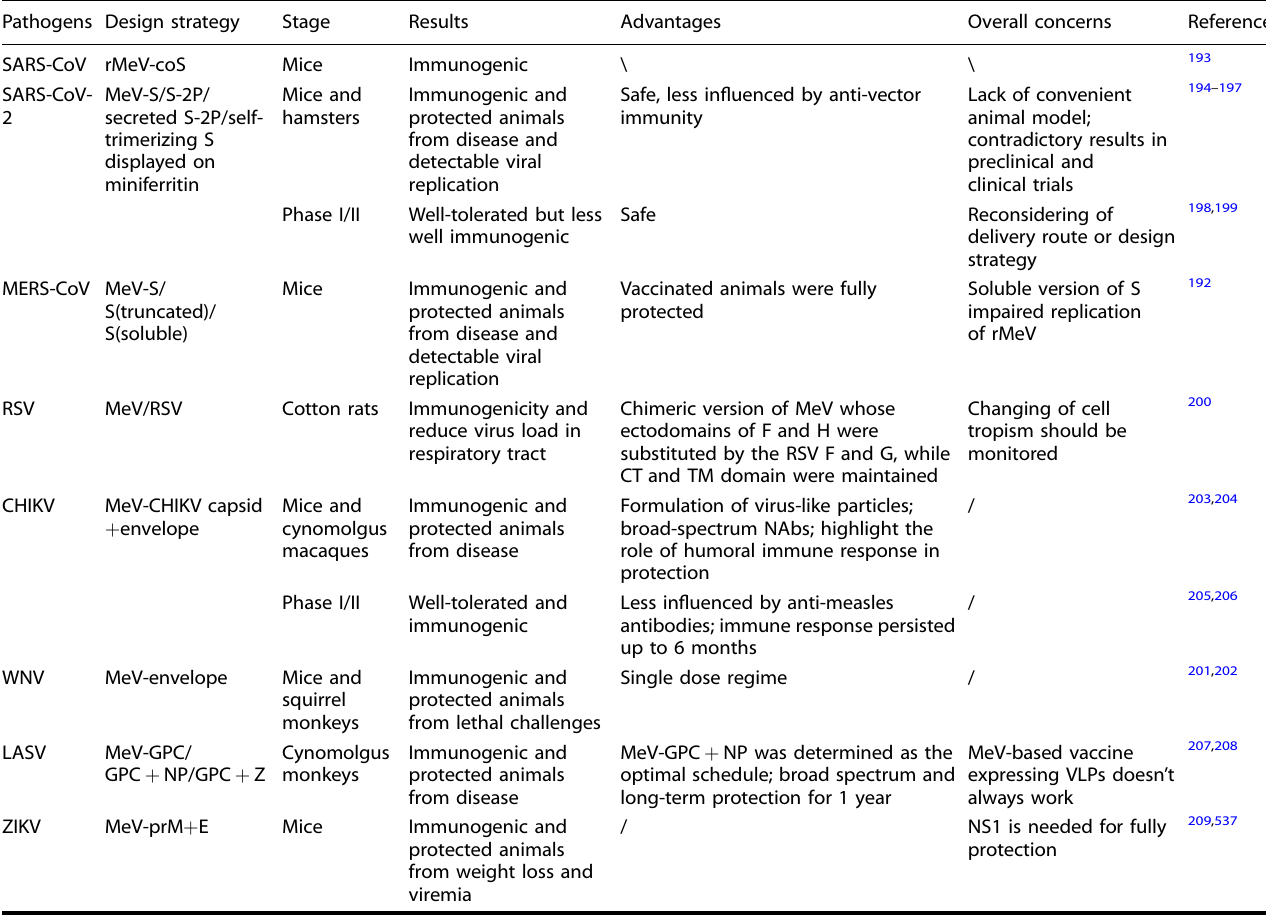
Table 5. Vaccines based on measles virus vector Pathogens Design strategy Stage Results Advantages Overall